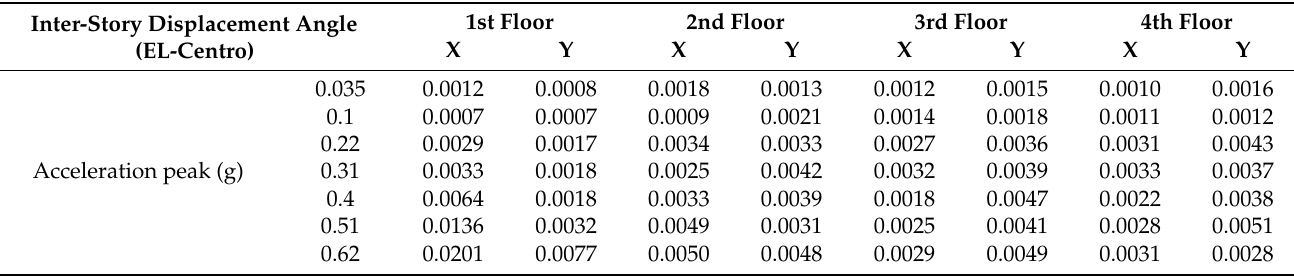
Table 6. Inter-story displacement angle (EL-Centro).